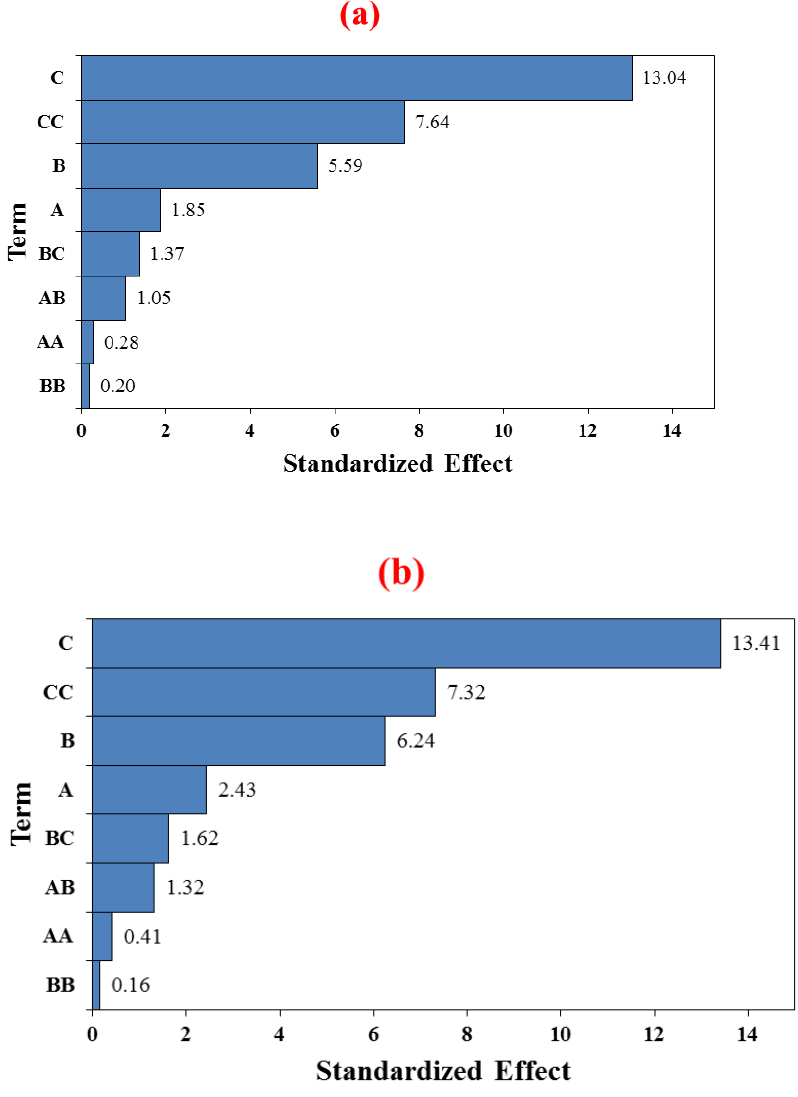
Figure 1. Pareto chart of the standardized effects of three parameters—pH (A), concentration (B), and MCM-41 wt.% (C)—on the permeability of ( a ) AB-210, and ( b ) RB dyes. The content of the MCM-41 wt.% in the casting solution (factor C) and the concentra- tion of the AB-210 dye solution (factor B) both exceeded the critical value (i.e., they